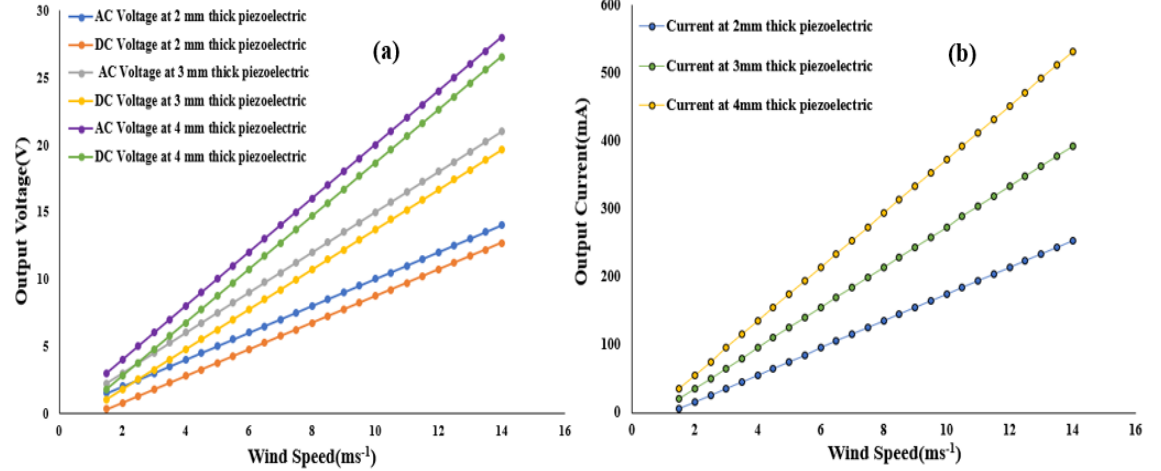
Figure 7. Electrical output of harvester via wind speed. ( a ) Output voltage, ( b ) Output current.